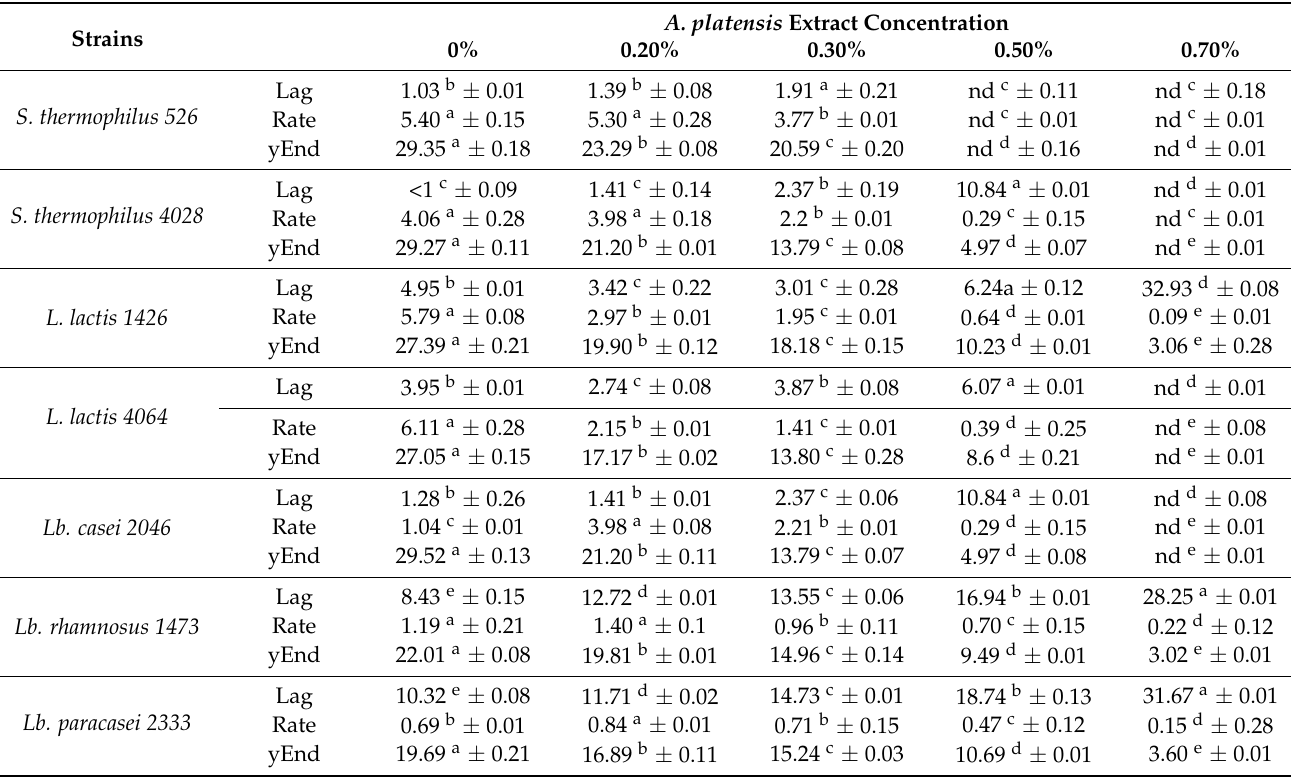
Table 2. Lag, Rate, and yEnd parameters of the seven considered strains grown in skimmed milk (SSM) with different A. platensis extract